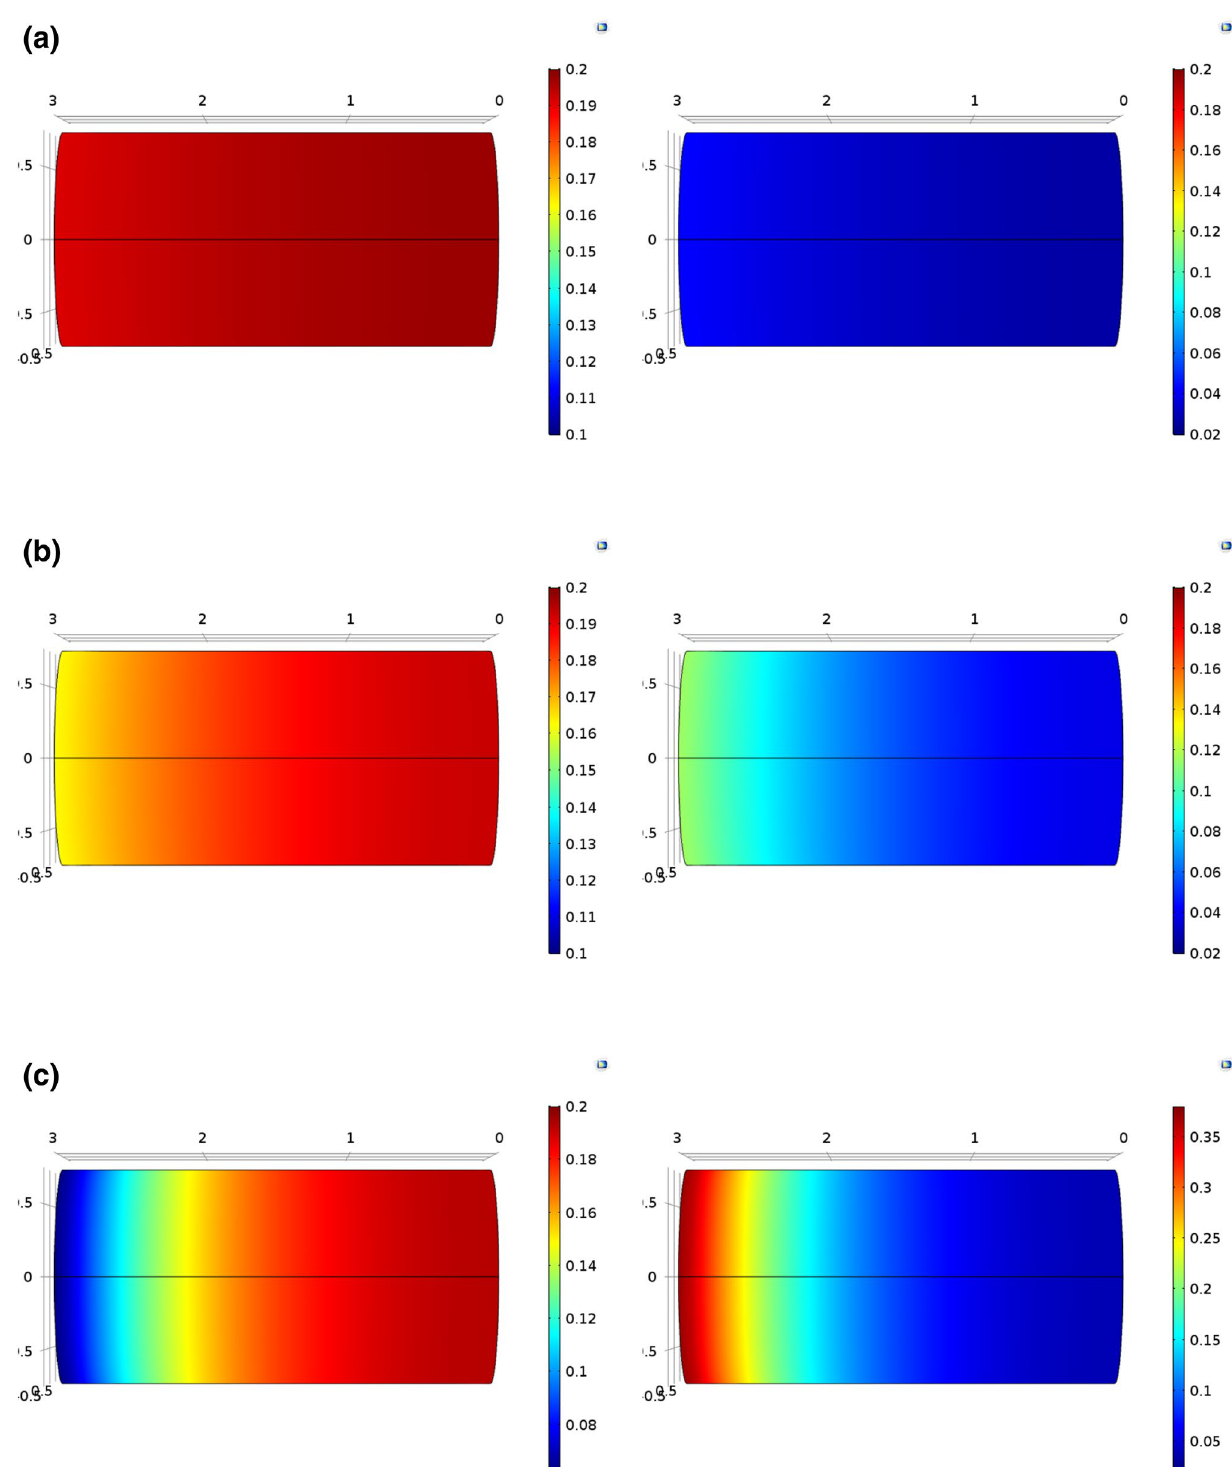
Fig. 18 Fast-reacting mineral (left) and silica gel (right) distribution after 35 min of fluoroboric acid injection at a 25 °C, b 65 °C and c 105